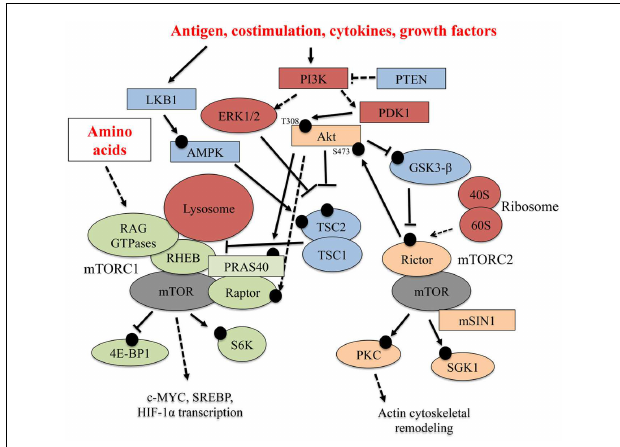
FIGURE 1 | Select upstream regulators and downstream effectors of mTOR signaling . Multiple signaling pathways emanating from theTCR, co-stimulatory receptors, cytokines, and nutrients (amino acids) tune mTOR activation inT cells. In this figure, black circles represent phosphorylation events. Solid arrows indicate a direct, activating phosphorylation event mediated by an upstream kinase, while dashed arrows indicate an indirect, positive regulatory role for a protein in a particular pathway. Inhibitory phosphorylation events or control of pathway activation are indicated by solid or dashed flat-ended arrows,